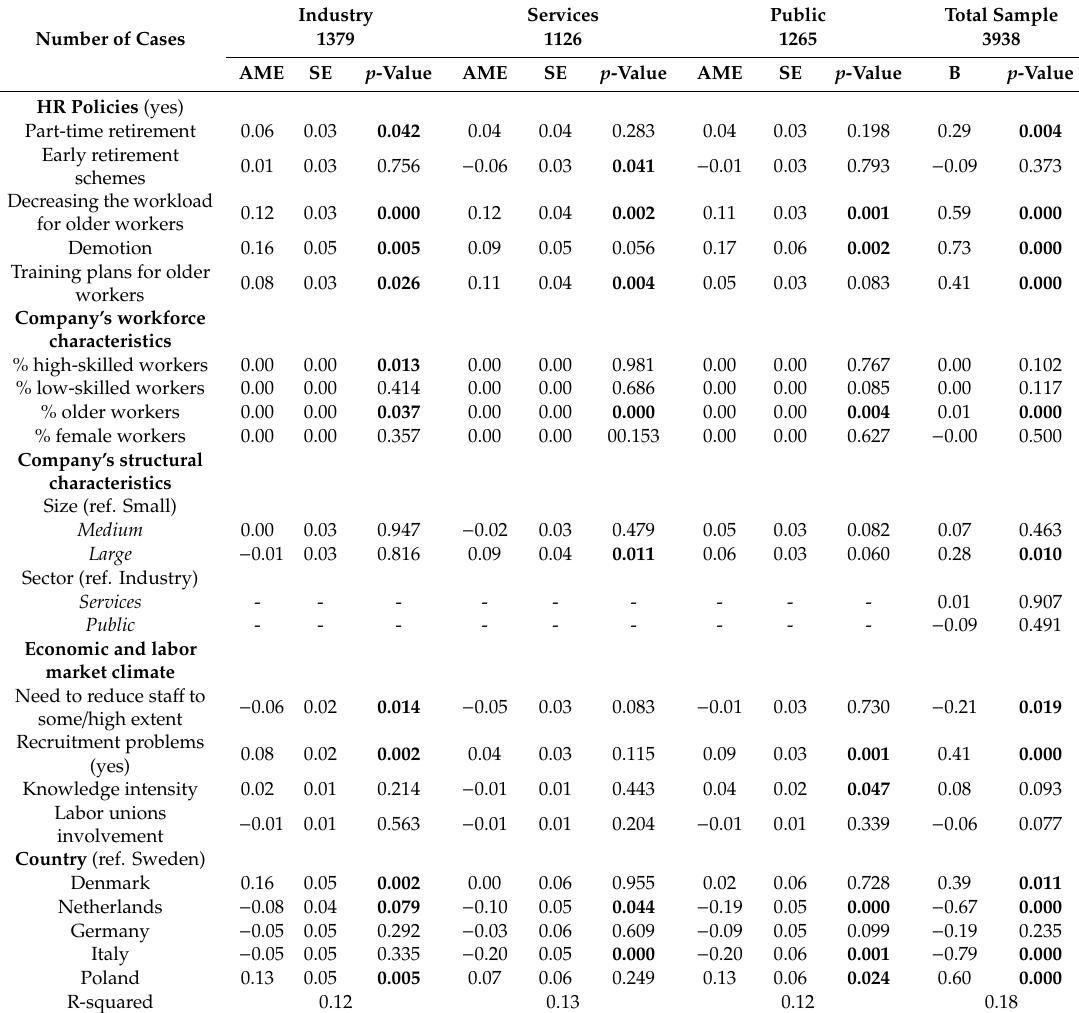
Table 2. Explanatory variables for encouraging working until statutory retirement age, by sector and total sample. Industry